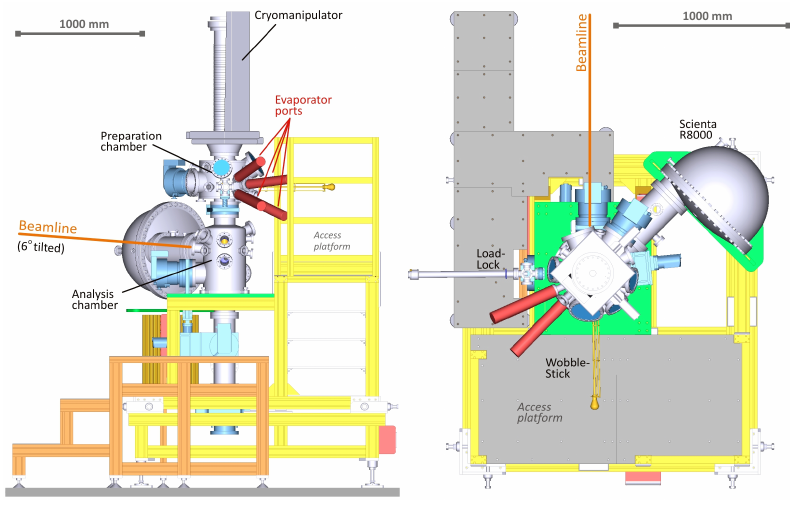
Figure 2: Technical design of ARPES 1 2 endstation. Side and top